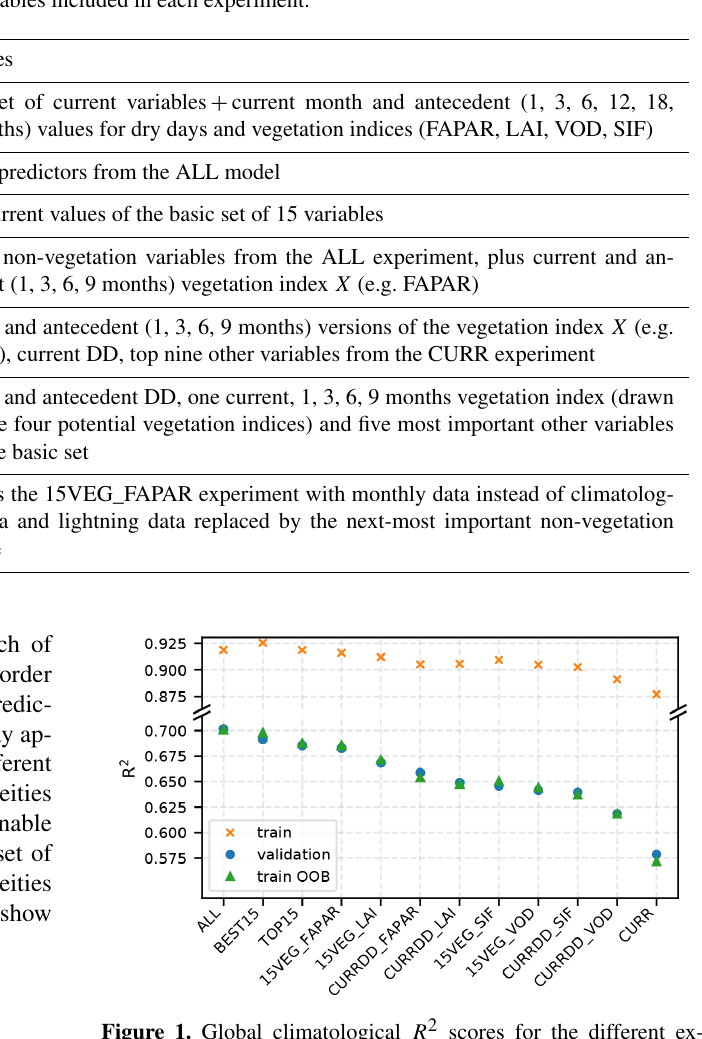
Table 2. The modelling experiments. Except for the ALL experiments, the other experiments included 15 predictor variables for compara- bility. Differences in number of antecedent variables included in each experiment meant that different numbers of variables from the basic set were used in these experiments. For the TOP15, 15VEG_X(_MON), and BEST15 models we used the most important variables from the ALL experiment up to the required number of 15. For the CURRDD_X models, we used the most important non-vegetation variables from the CURR model. Table S1 provides a detailed list of the variables included in each experiment.